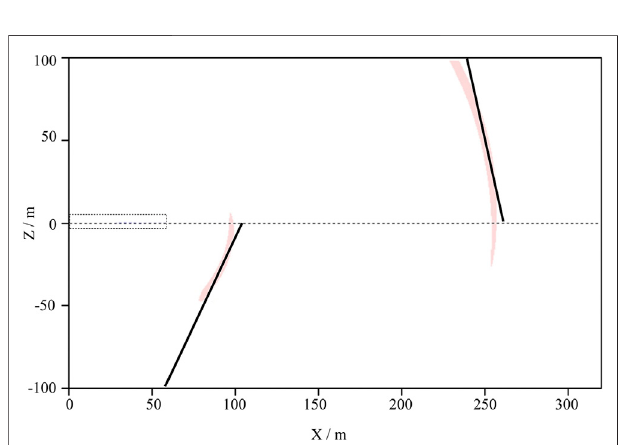
FIGURE 8 | Polarization migration results of two re fl ection interfaces. The polarization migration results of the two-layer interface can be obtained, as shown in the red arc in the fi gure. Under the control of the principal polarization angle, the interface angles of the two layers are 65 ° and 78 ° respectively. The black lines are tangent to the red arcs and in line with the angle, and the lines are selected to the location of the re fl ection interfaces.